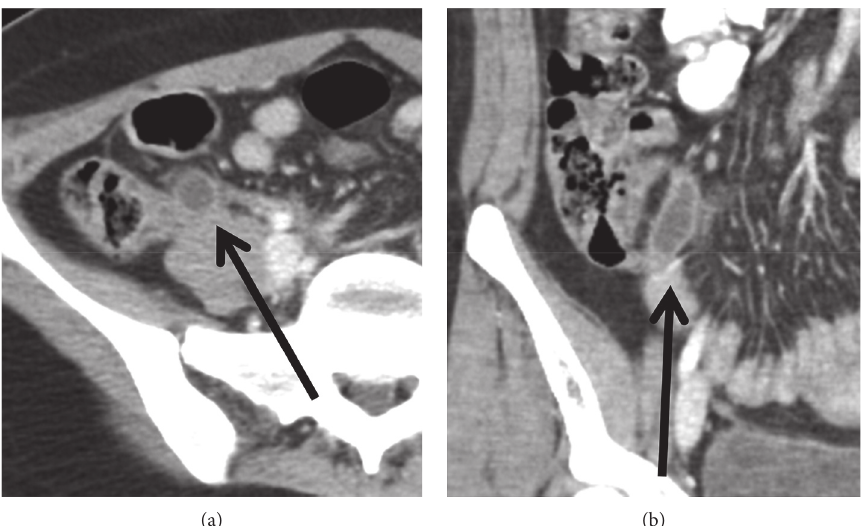
Figure 1: CT scan (transverse and coronal cut). Thickened fluid-filled appendix with localized fat stranding; an appendiceal diverticulum cannot be seen.